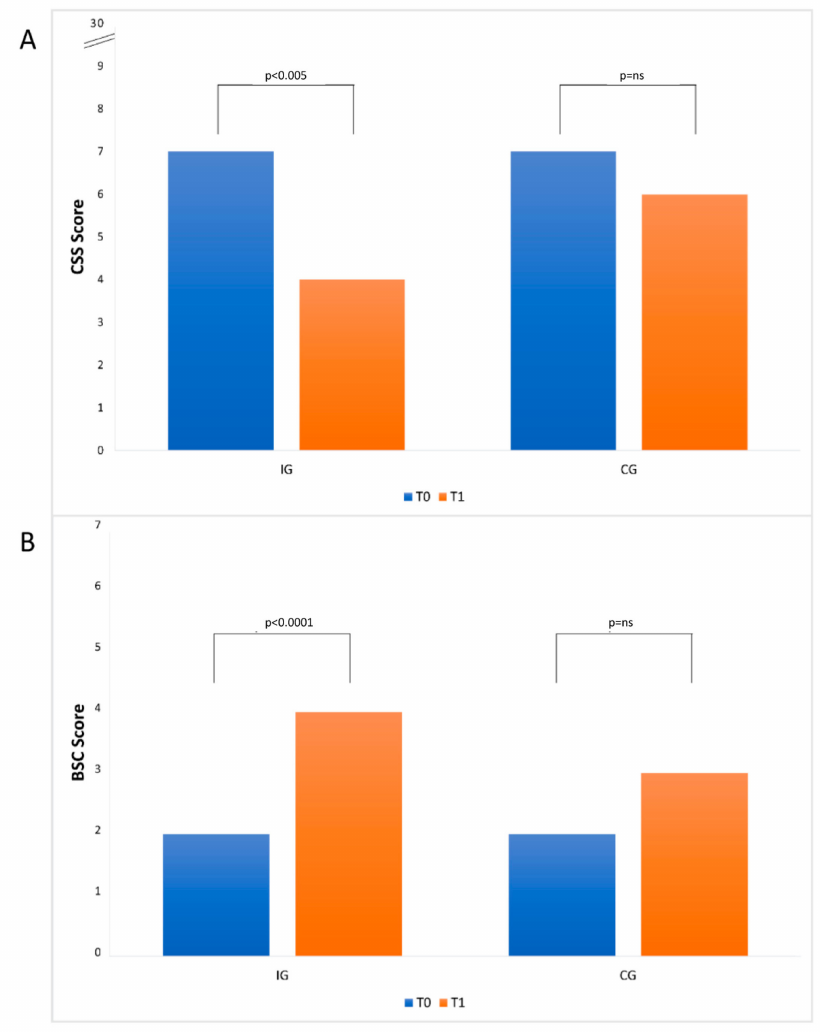
Figure 1. Histograms of constipation scoring system (CSS) ( A ) and Bristol Stool Chart (BSC) ( B ) for IG and CG groups at T 0 and T 1 . Panel A: The y -axis reports a portion of the score’s scale (from 0 (absence of constipation) to 30 (maximum grade of constipation)) at T 0 and T 1 ; panel B: the y -axis reports a portion of the score’s scale (from 1 (maximum grade of stool hardness) to 7 (entirely liquid stool)) at T 0 and T 1 . In both histograms, the median values of each score are reported. 3.3. Composition of Intestinal Microbiota at Baseline (T 0 ) and after Four Months of Intervention (T 1 ) Ecological analyses were conducted on the patients’ cohort in order to analyse GM OTUs ecology and global distribution. Beta diversity indices (i.e., weighted and un- weighted UniFrac) did no detect any statistically significant differences between T 0 and T 1 for the IG and CG groups (Adonis test p > 0.05; Figure